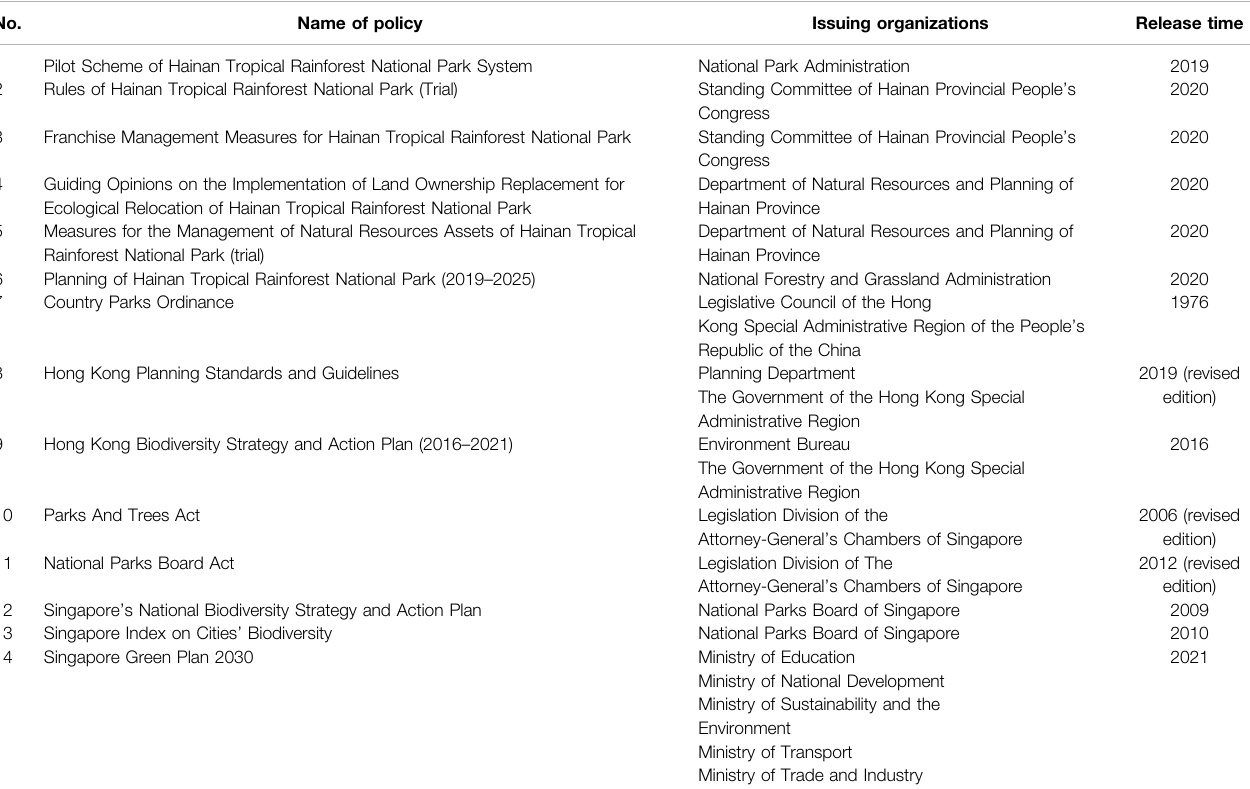
TABLE 1 | Samples of national park policies in Hainan, Hong Kong, and Singapore.